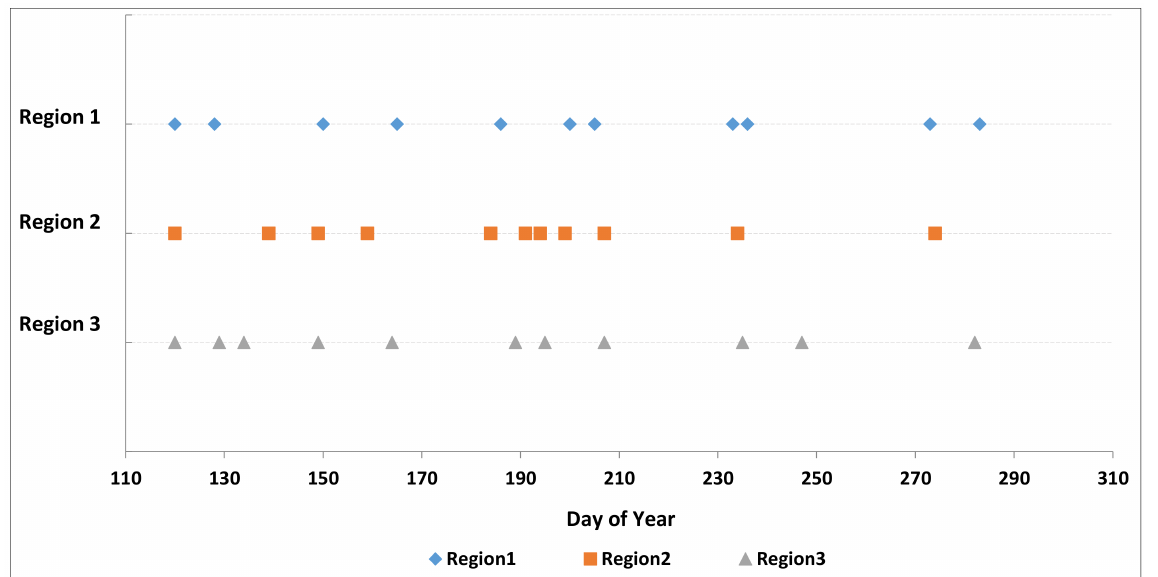
Figure 2. The image coverage of Sentinel-2 used in the three study areas.